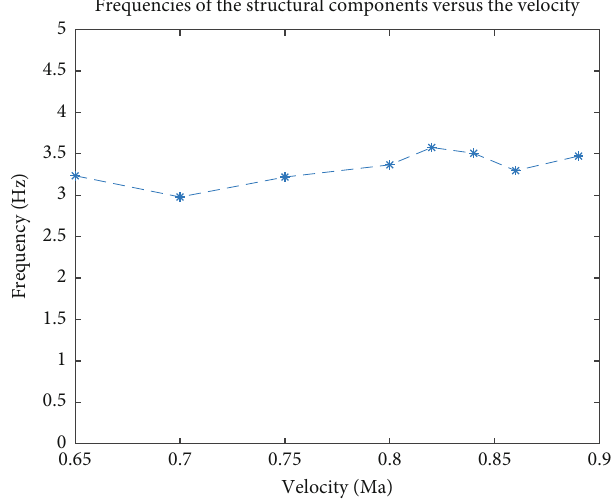
Figure 26: Frequency versus velocity diagram. fi tting. Table 3 analyzes the modal parameter calculation results of the frequency-spatial domain decomposition (FSDD) [14], SSI [15], and the proposed method.